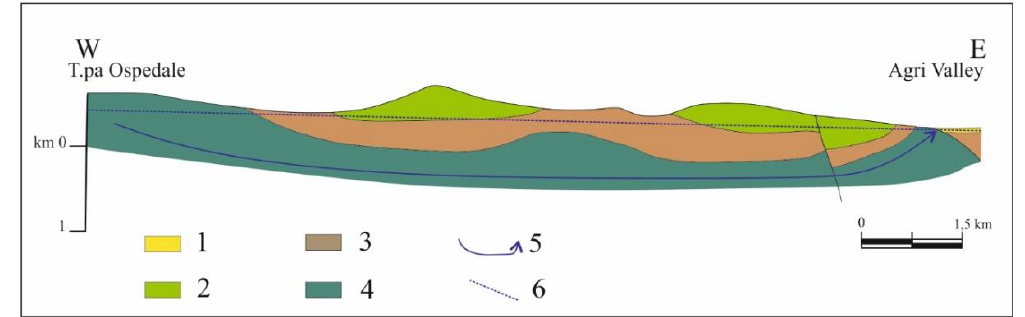
Figure 7. Hydrogeological sketch of the Scisti Silicei aquifer (based on the geological section of Menardi, Noguera, and Rea 2000 [30]). (1) alluvial complex; (2) carbonate complex; (3) low-permeability complex; (4) Scisti Silicei complex; (5) groundwater flow line; (6) hydraulic head.